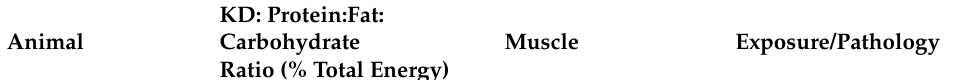
Exposure/Pathology Outcome Ref. Exercise